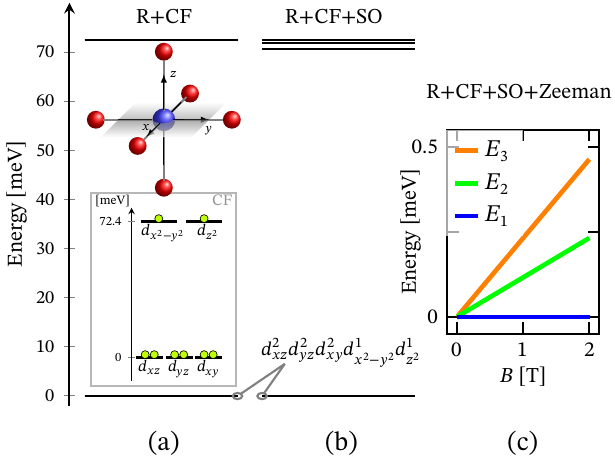
Figure 2. Low-lying energy level structure for an octahedral geometry, with model parameters given at the end of Section 2.1. ( a ) Shows the splitting occurring due to the action of CF under the repulsive Coulomb interactions. The corresponding CF orbital energy diagram is also depicted, where the lime colored circle represent an electron. ( b ) Depicts the added contribution of spin-orbit interactions. Subfigure ( c ) shows the Zeeman